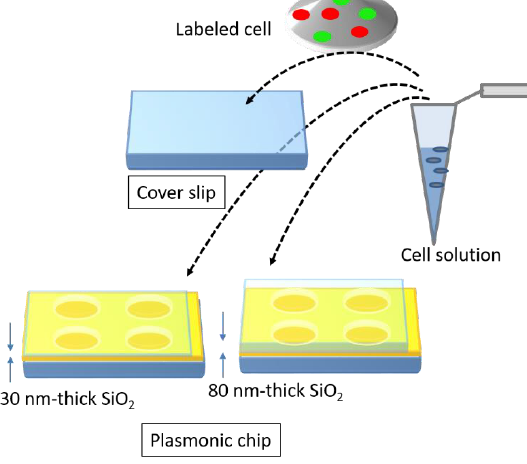
Figure 2. Schematic of a brief concept in this study.